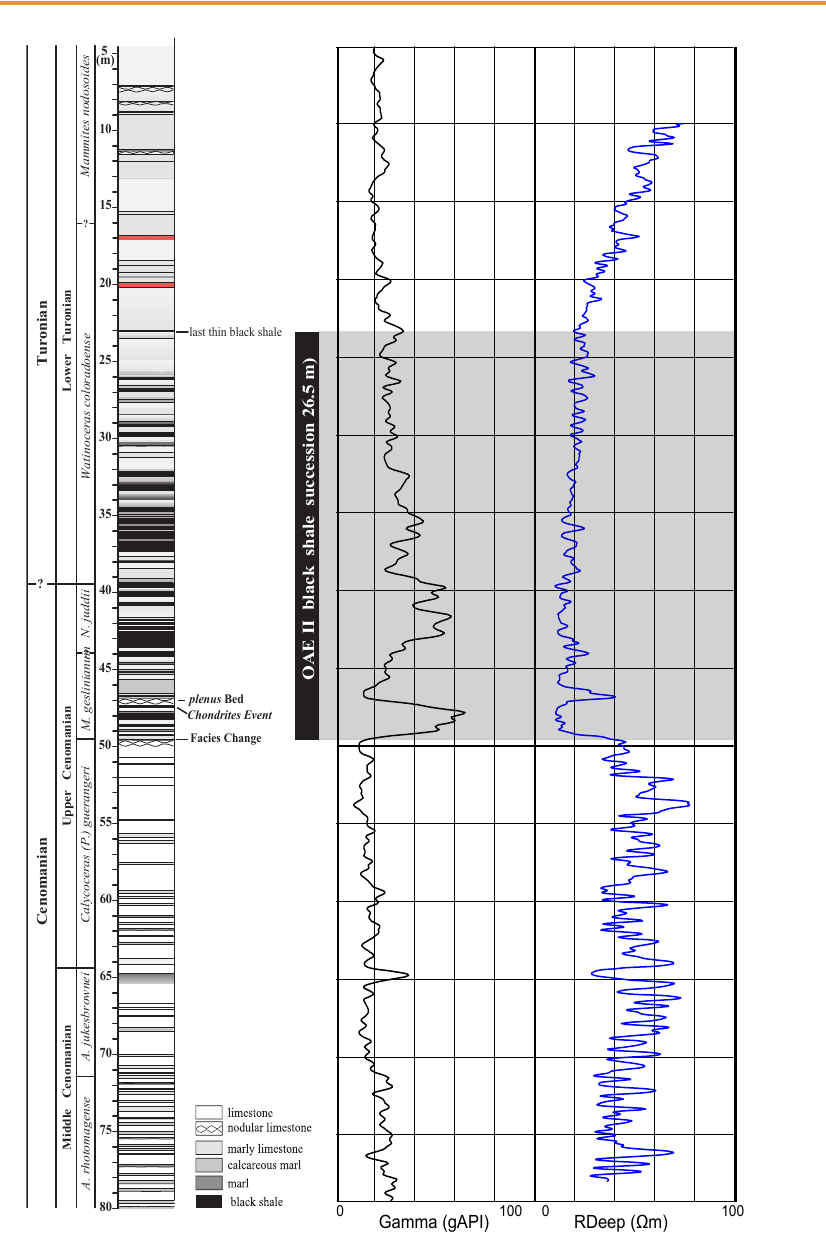
Figure 4. Schematic litholog of the Middle Cenomanian–Lower Turonian of the Wunstorf Core, plus γ -ray and resistivity downhole logs. Columns in litholog from left to right show stages, substages, ammonite biozones, depth in meters below surface, lithology, and prominent lithos- tratigraphic